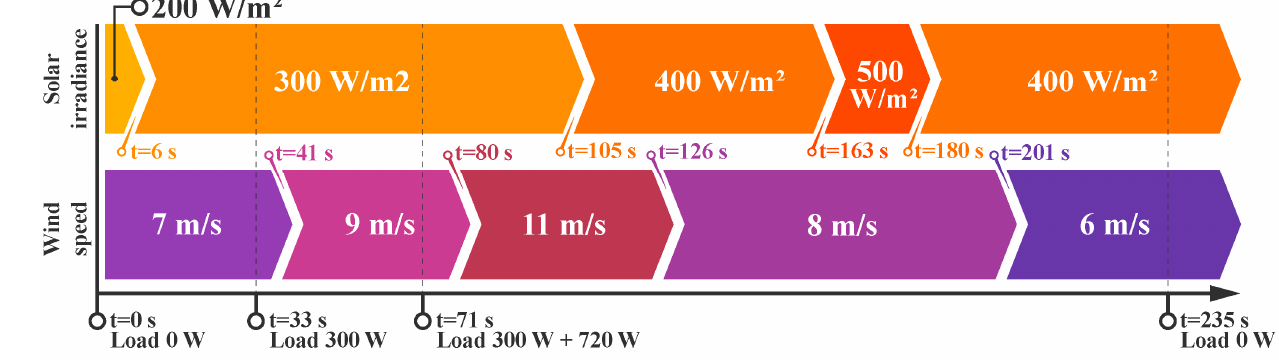
Figure 14. Timeline of events in the island operation experiment.